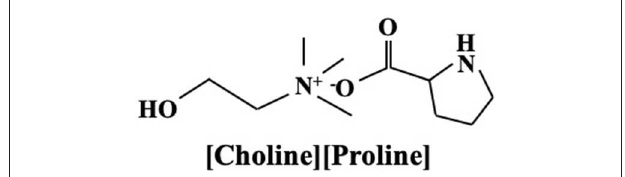
FIGURE 1 | Molecular structures of [Choline][L-Proline].